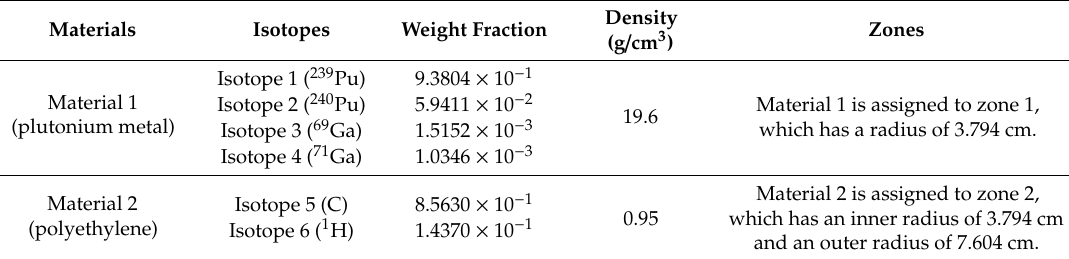
Table 1. Dimensions and material composition of the PERP